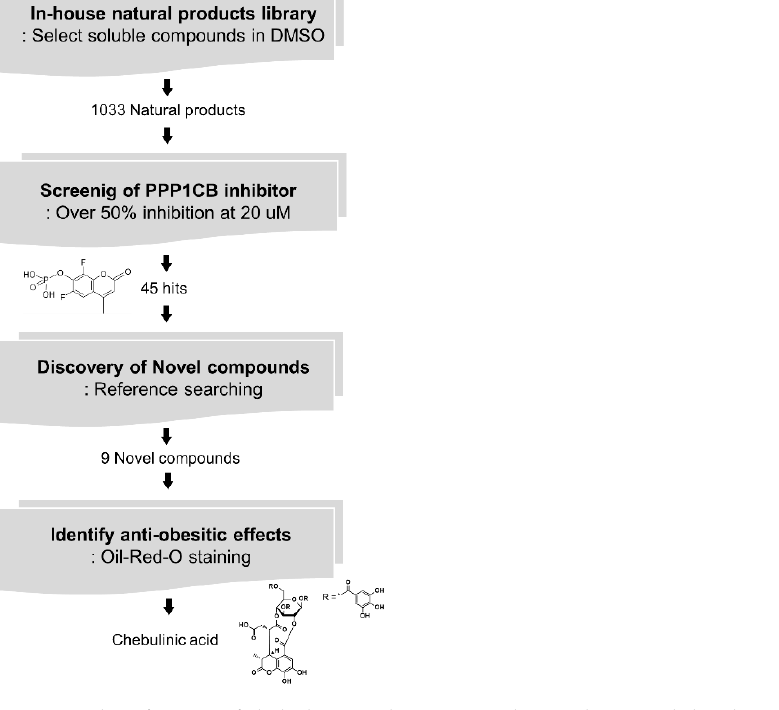
Figure 1. Identification of chebulinic acid as an anti-obesity drug candidate by screening of 1033 natural products for PPP1CB inhibitors. A total of 1033 natural products were transferred to black/black bottom 96-well plates and enzymatic screening was performed with PPP1CB. Inhibitory activity of each compound was evaluated using 6,8-difluoro-4-methylumbelliferyl phosphate (DiFMUP)-based assays, and the inhibitory effects of the 1033 natural products on PPP1CB were calculated using control-based normalization. The top 45 hits were selected. Among the 45 hits, nine compounds that have not reported anti-adipogenic effects were sorted based on literature search. These nine selected compounds were evaluated using oil red O staining to determine whether they suppress adipogenesis in 3T3-L1 cells. Finally, chebulinic acid was selected as the most potent compound for obesity